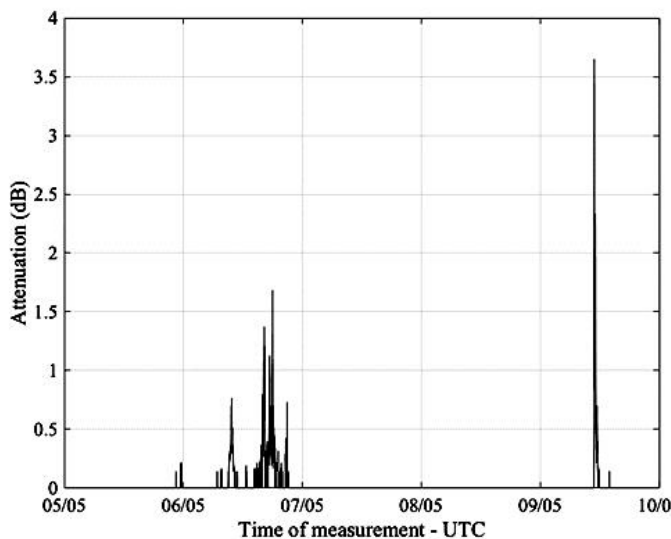
Figure 10. Calculated signal attenuation in Pisa, Italy, 5–10 May 2017.